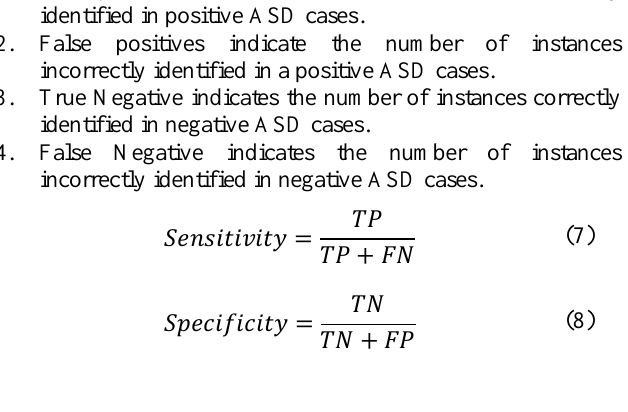
Table 4. Confusion Matrix for ASD